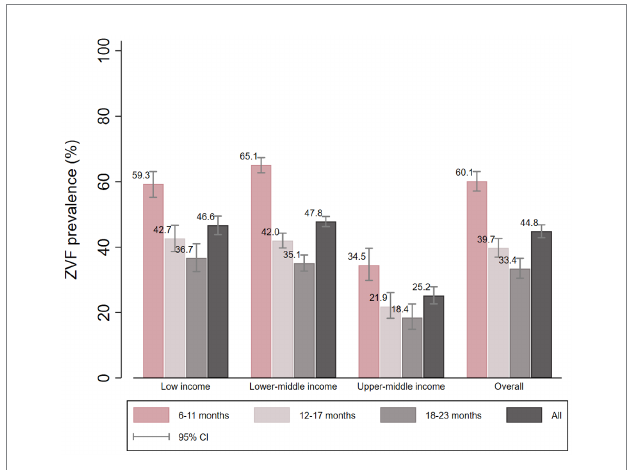
FIGURE 1 ZVF prevalence according to country income and child age